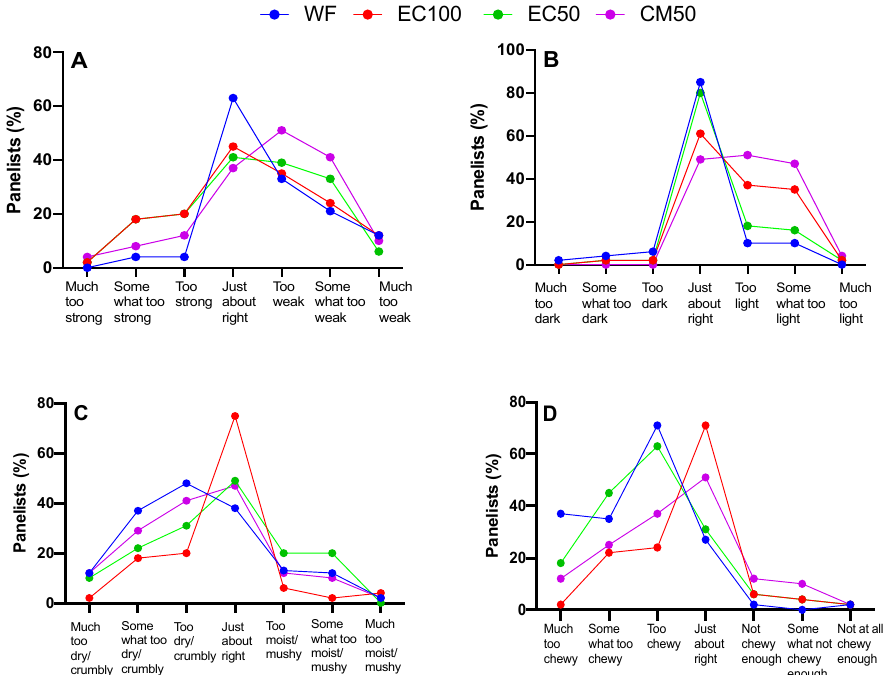
Figure 7. Just-about-right scales (% panelists) of whole wheat flour (WF) roti (Indian flat bread) samples fortified with encapsulated defatted Nannochloropsis oceanica (EC) and color-masked defatted Nannochloropsis oceanica (CM) at day 21 on ( A ) flavor, ( B ) color, ( C ) dry vs moist and ( D ) chewiness; n = 51.